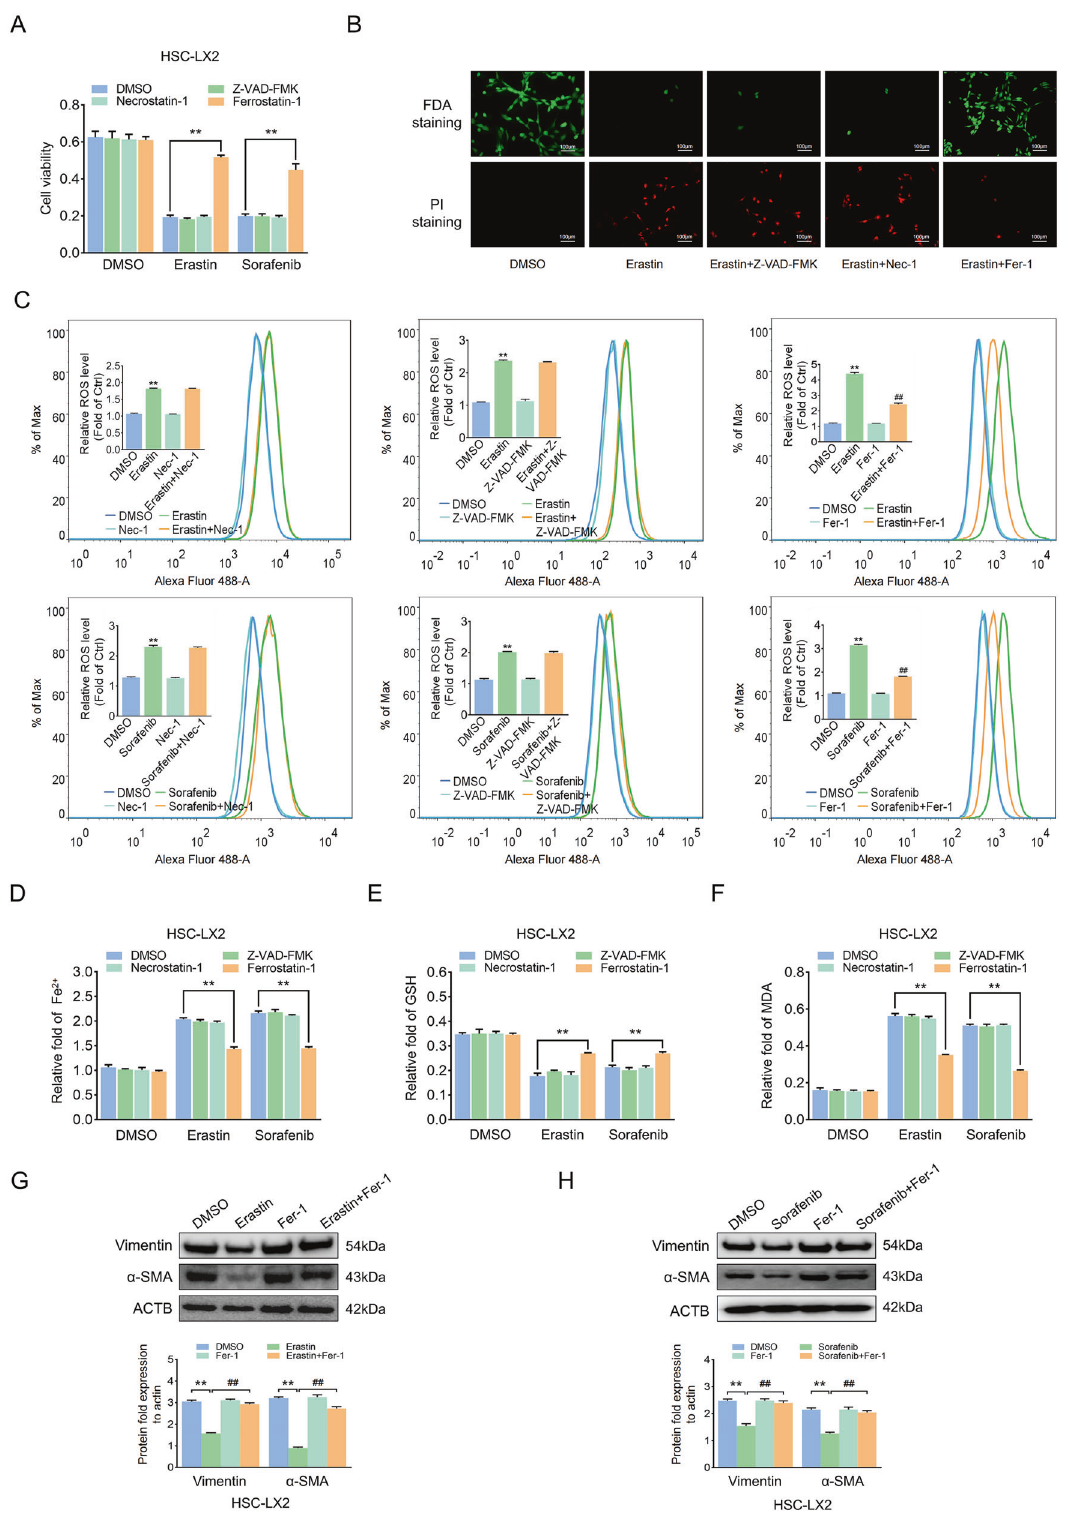
Fig. 3 Ferroptosis contributes to the inhibition of HSC activation. HSC-LX2 cells were treated with erastin (10 μ M) and sorafenib (10 μ M) with or without the indicated inhibitors (Z-VAD-FMK, 10 μ M; Fer-1, 1 μ M; necrostatin-1, 10 μ M) for 24 h. A Cell viability was assayed by CCK-8. B Live cells and dead cells were assayed by FDA staining and PI staining, respectively. C – F ROS generation, cellular Fe 2 + , GSH depletion, and lipid peroxidation MDA production was assayed. G , H Vimentin and α -SMA protein levels were assayed. The results are expressed as mean ± SD. Data are representative of three independent experiments; n = 3 – 6 in every group; Scales: 100 μ m. Representative photographs are shown. Compared with the control group, ** P < 0.01; compared with the ferroptosis-inducer group, ## P <